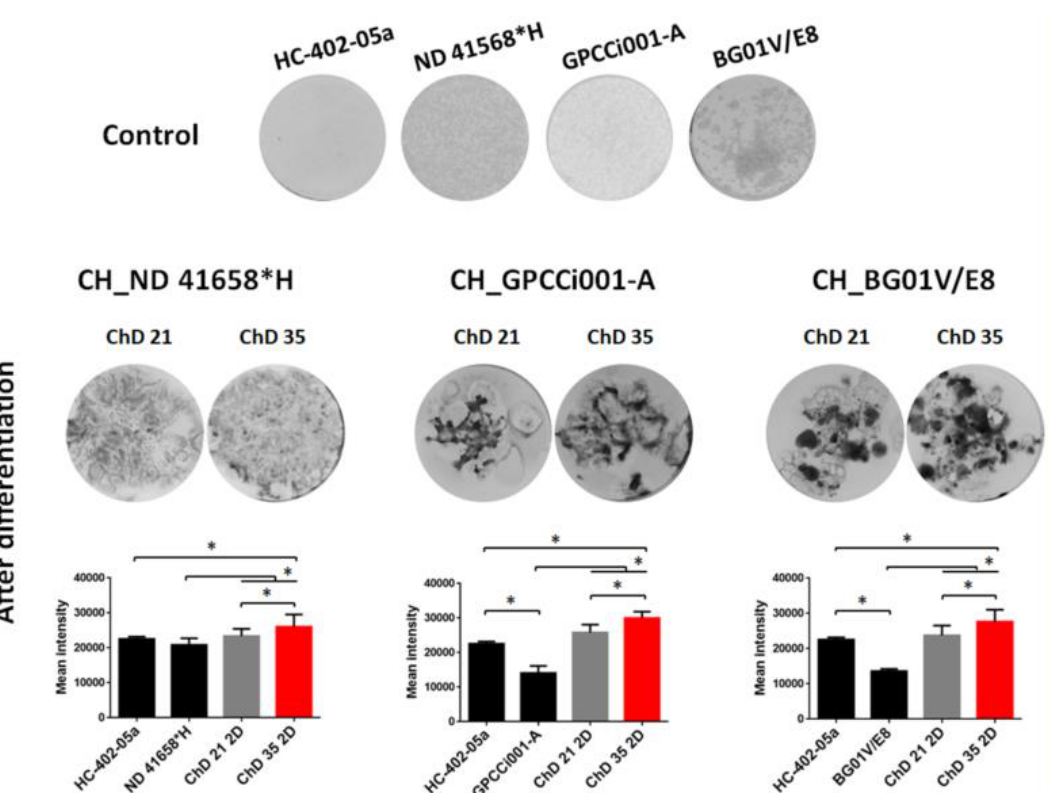
Figure 5. Prolonged chondrogenic differentiation in monolayer culture caused increased deposition of proteoglycans. After chondrogenic differentiation of pluripotent cell lines after 21 and 35 days of chondrogenic culture, the alcian blue staining and semi-quantification of staining density were performed. The increased deposition of proteoglycans was observed in EB outgrowth after 35 days in comparison with the 21 day and control populations. The pictures represent well of 12-well plate. The graphs represent mean density and error bars indicate SD ( n = 6, one-way ANOVA; * p < 0.05).